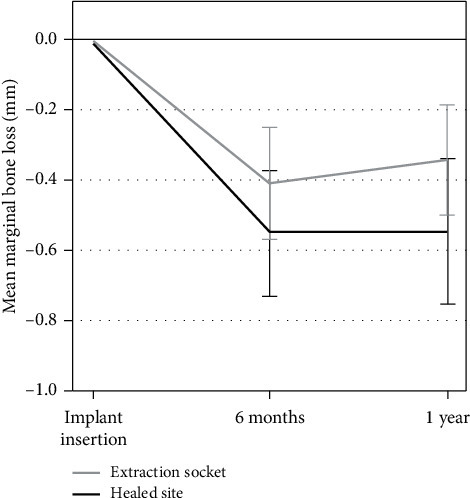
Mean marginal bone remodeling from the time of implant placement to 1-year follow-up comparing implants placed in healed sites vs extraction sockets. Error bars show the standard error of the mean (SEM).